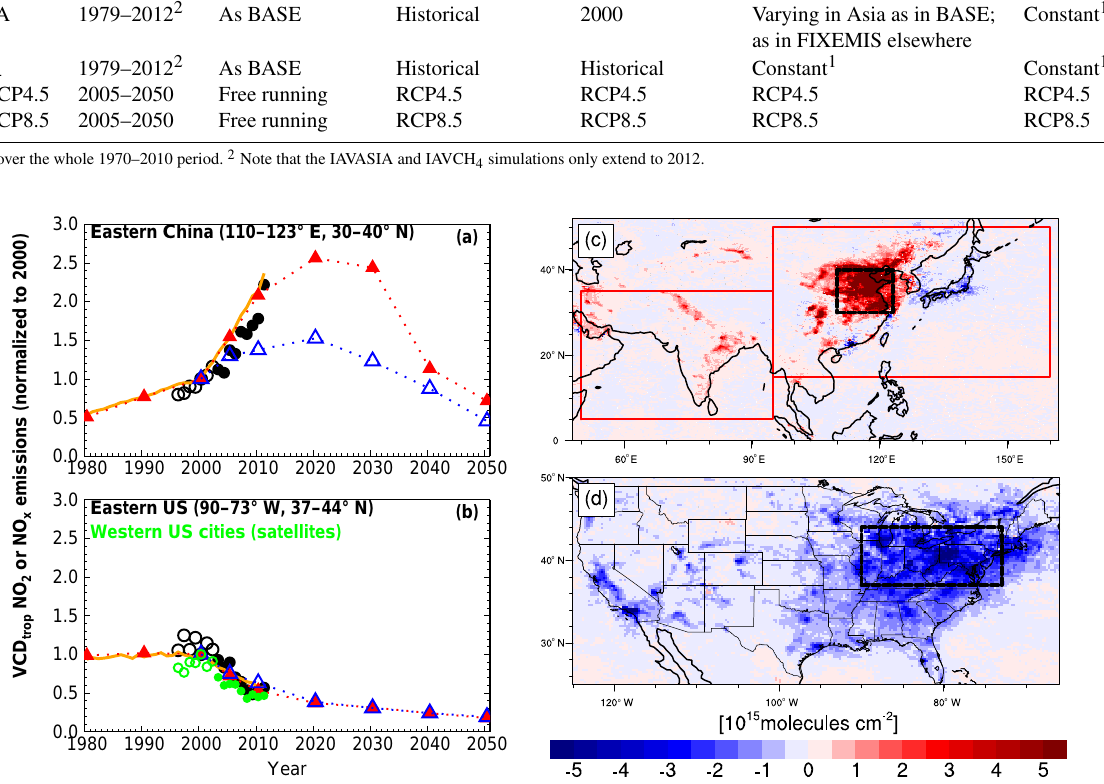
Figure 1. Changes in NO x emissions. (a–b) Mean annual vertical column densities of tropospheric (VCDtrop) NO 2 normalized to the year 2000 for the eastern China and eastern US domains (black boxes on map) from GOME (1996–2002, open circles) and SCIAMACHY (2003– 2011, closed circles) measurements and AM3 BASE simulations (orange lines). Triangles indicate trends in NO x emissions (normalized to 2000) from Lamarque et al. (2010) with annual interpolation after 2000 to RCP8.5 (red) versus RCP4.5 (blue). (c–d) Differences in